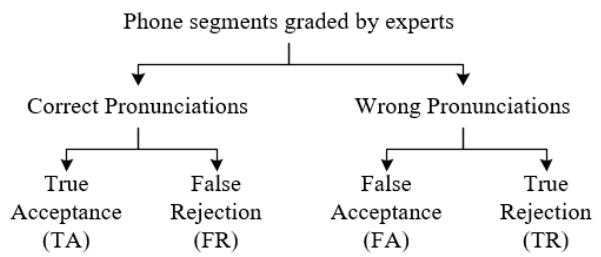
Figure 4. The hierarchical evaluation structures.